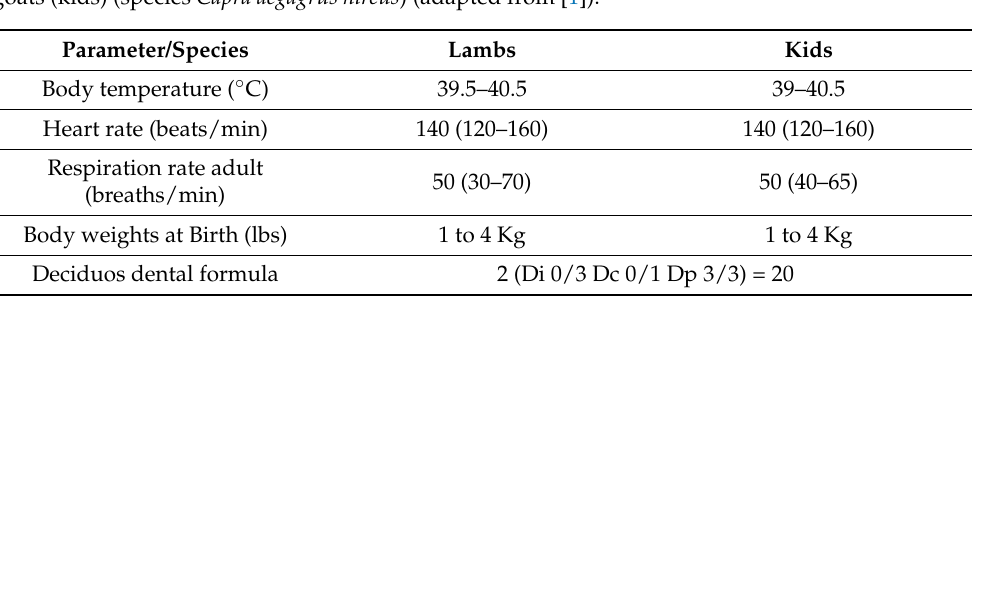
Table 2. Normal values of physiological parameters in young sheep (lambs) (species Ovis aries ) and goats (kids) (species Capra aegagrus hircus ) (adapted from